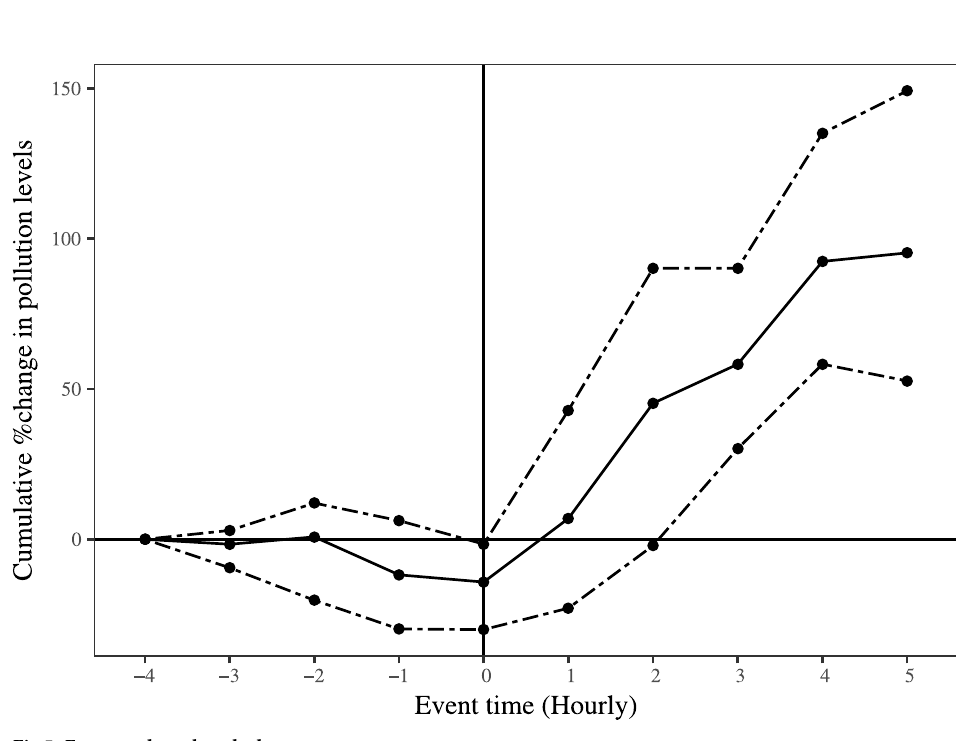
Fig 5. Event study on hourly